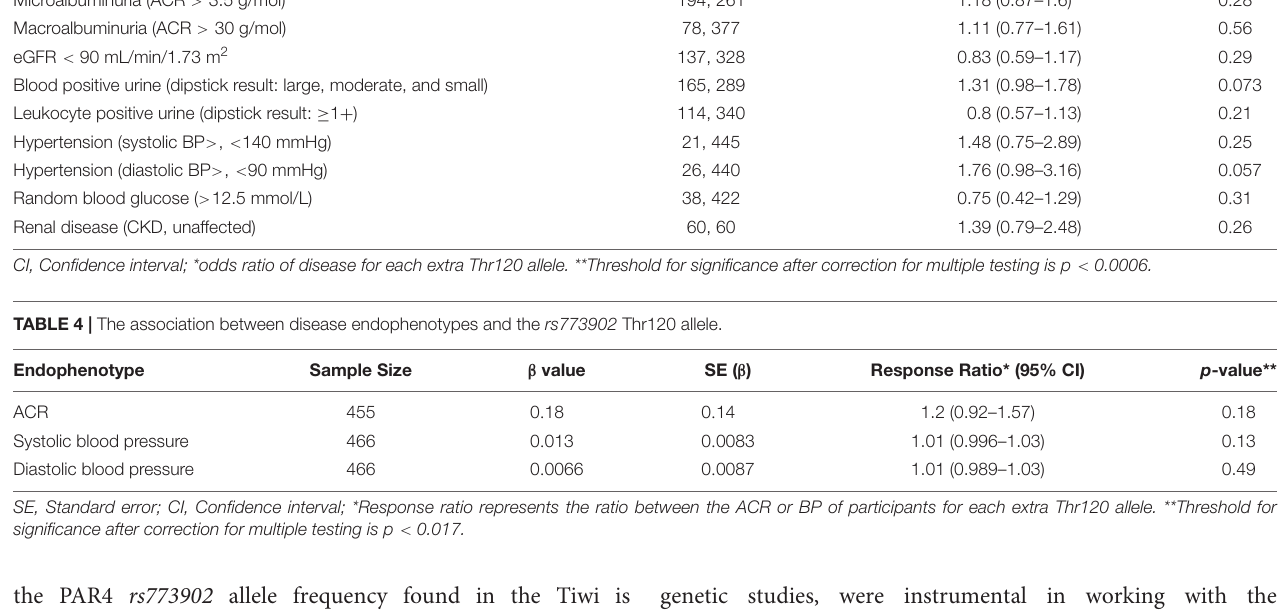
TABLE 3 | The association between disease markers and the rs773902 Thr120 allele. Disease Sample size (disease, control) Odds ratio* (95% CI) p- value** Microalbuminuria (ACR > 3.5 g/mol)